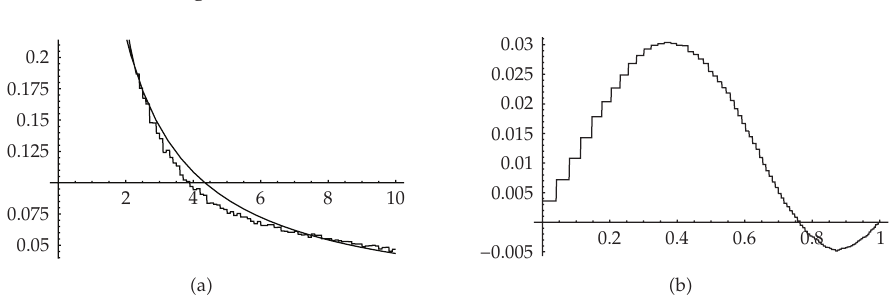
Figure 1: All 499999 di ff erences of adjacent order statistics from 500000 independent random variables from the Pareto distribution with minimum value and variance 1. (cid:5) a (cid:6) Observed digits of scaled di ff erences of adjacent random variables versus Benford’s law; (cid:5) b (cid:6) scaled observed minus Benford’s law (cid:5) cumulative distribution of base 10 logarithms (cid:6)